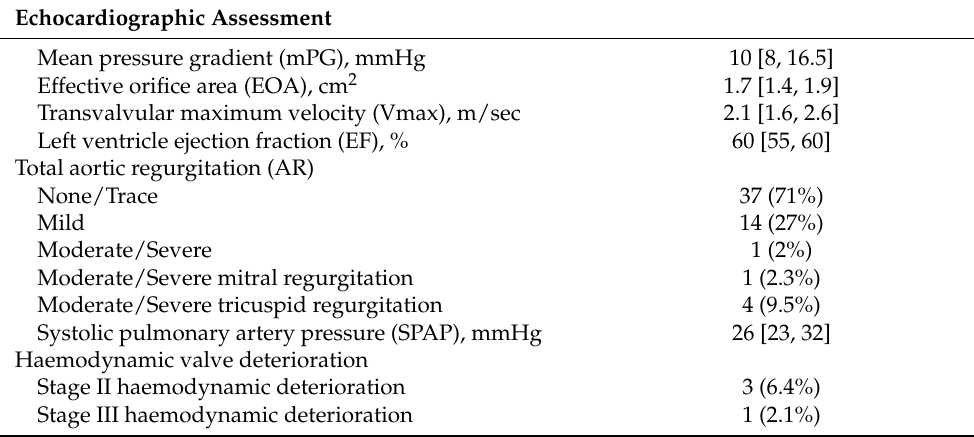
Table 3. Echocardiographic (haemodynamic) outcome at one-year follow-up. Echocardiographic